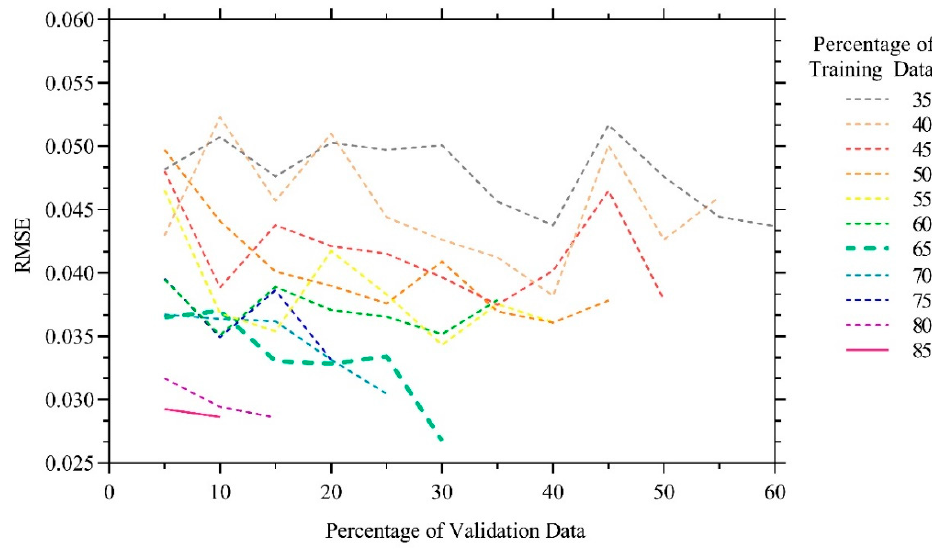
Figure 7. Effect of data proportioning on the performance of the one-hidden-layer MLP.